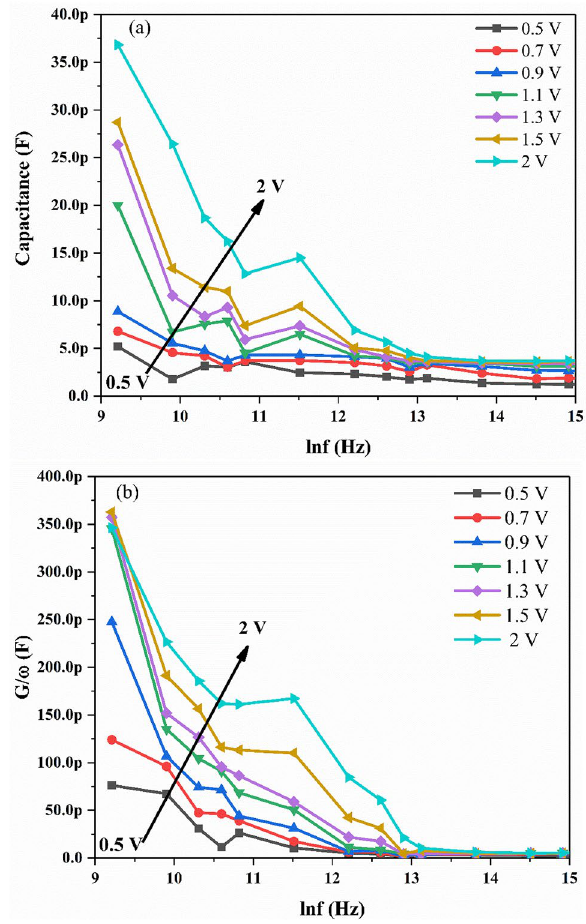
Figure 2. Plots of the ( a ) C-lnf and ( b ) G/ω-lnf for the Ag/TiO 2 -NW/Ge-NW/Si (MOS)